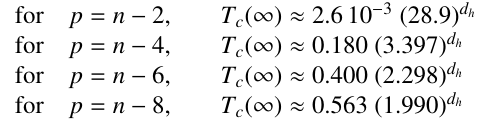
corresponding to the square lattice. The determination co- e ffi cients R 2 of the least square linear fits di ff er from 1 by less than 10 (cid:0) 4 for p = n (cid:0) 4, p = n (cid:0) 6 and p = n (cid:0) 8, less than 10 (cid:0) 3 for p = n (cid:0)